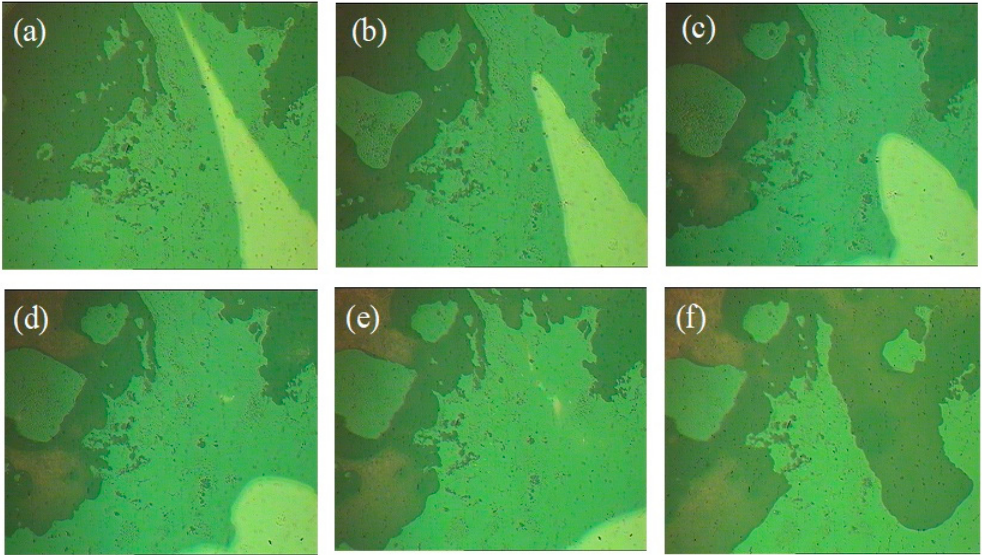
Figure 9. Self-healing process of PI-UPy observed with POM: ( a ) two parts put together; ( b – e ) the healing process of the elastomer sample; ( h ) the elastomer sample healed after heating.